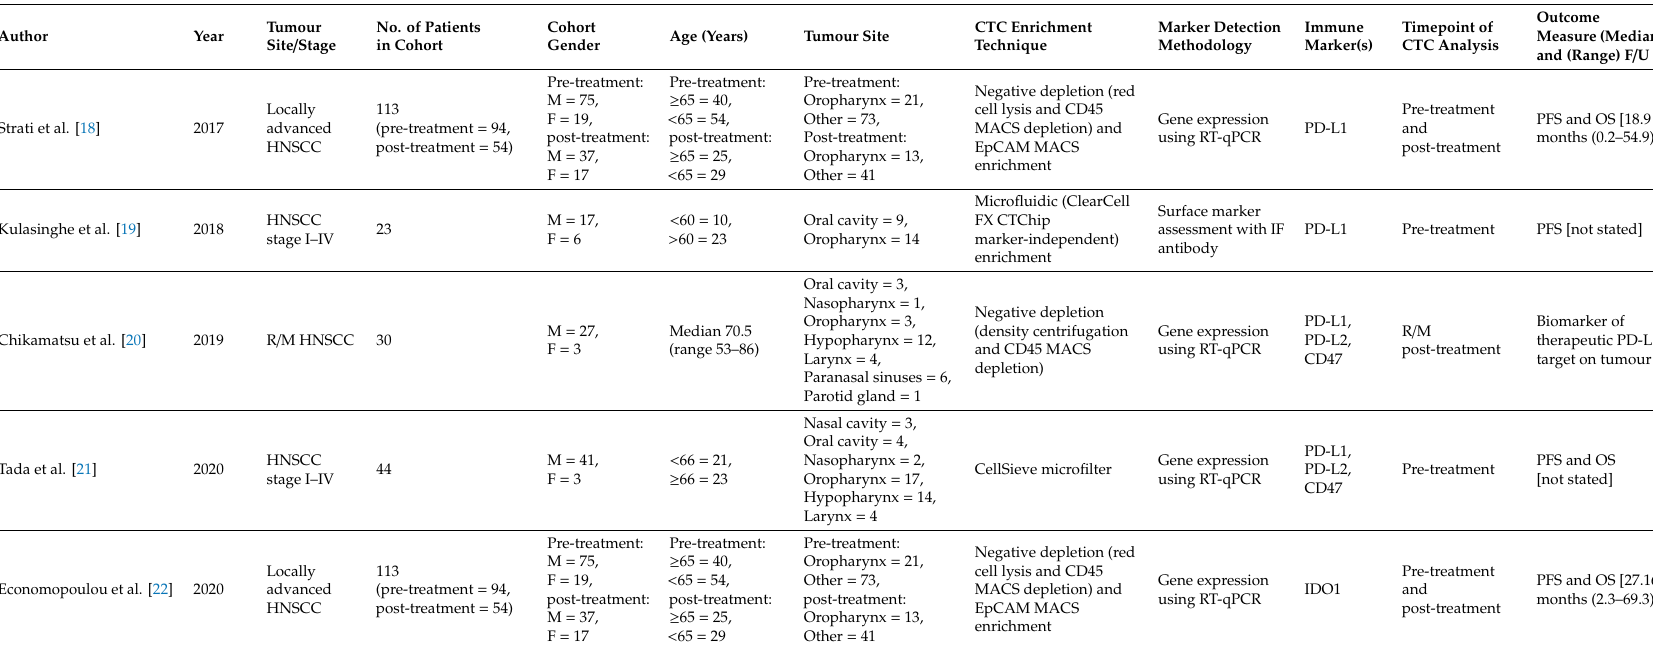
Table 1. Data of clinicopathological variables, CTC enrichment / detection methods, and investigated marker / clinical outcome as extracted from included studies. (HNSCC: head and neck squamous cell carcinoma, PFS: progression free survival, OS: overall survival, MACS: magnetic assisted cell sorting, R / M: recurrent / metastatic, F / U: